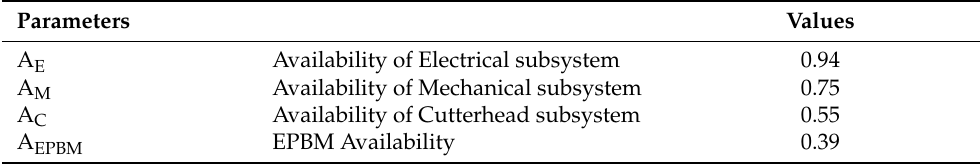
Table 3. Availability of EPBM and its subsystems in Line 1 using the networking method.